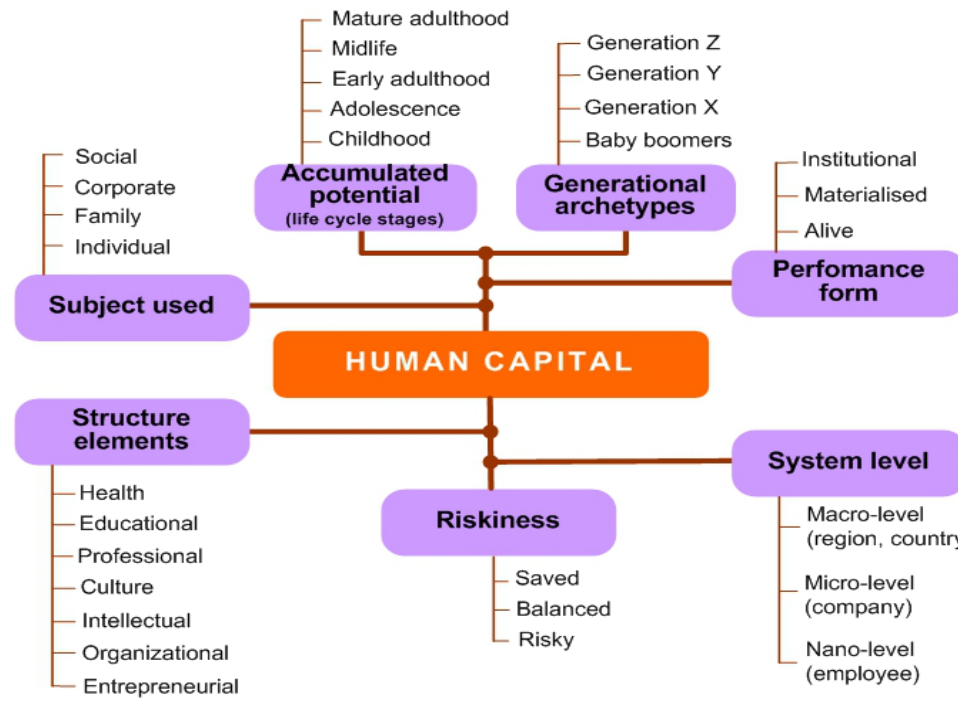
Figure 2. HC typology.